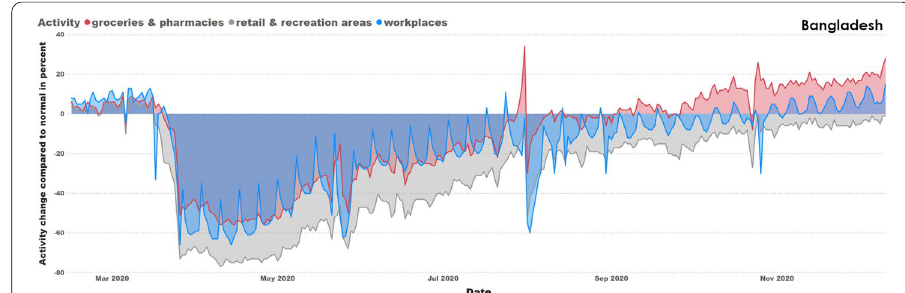
Fig. 12 Trended gradual return to full activity